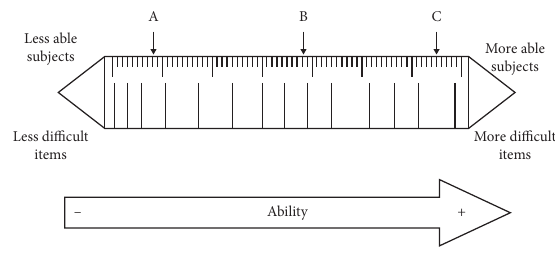
Figure 1: Rasch model